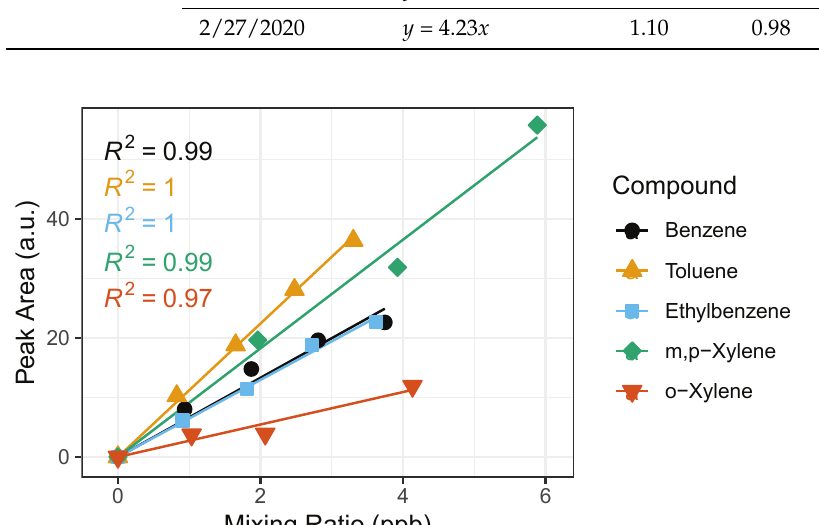
Figure 6. Example of calibration curves for BTEX compounds with the time-varying calibration method using sampling volumes: 0.5, 1.0, 1.5 and 2.0 L. The horizontal error bars represent uncertainty from the certified gas standard, while the vertical error bars (smaller than symbol) represent random instrument error. The corresponding R 2 is shown for each BTEX